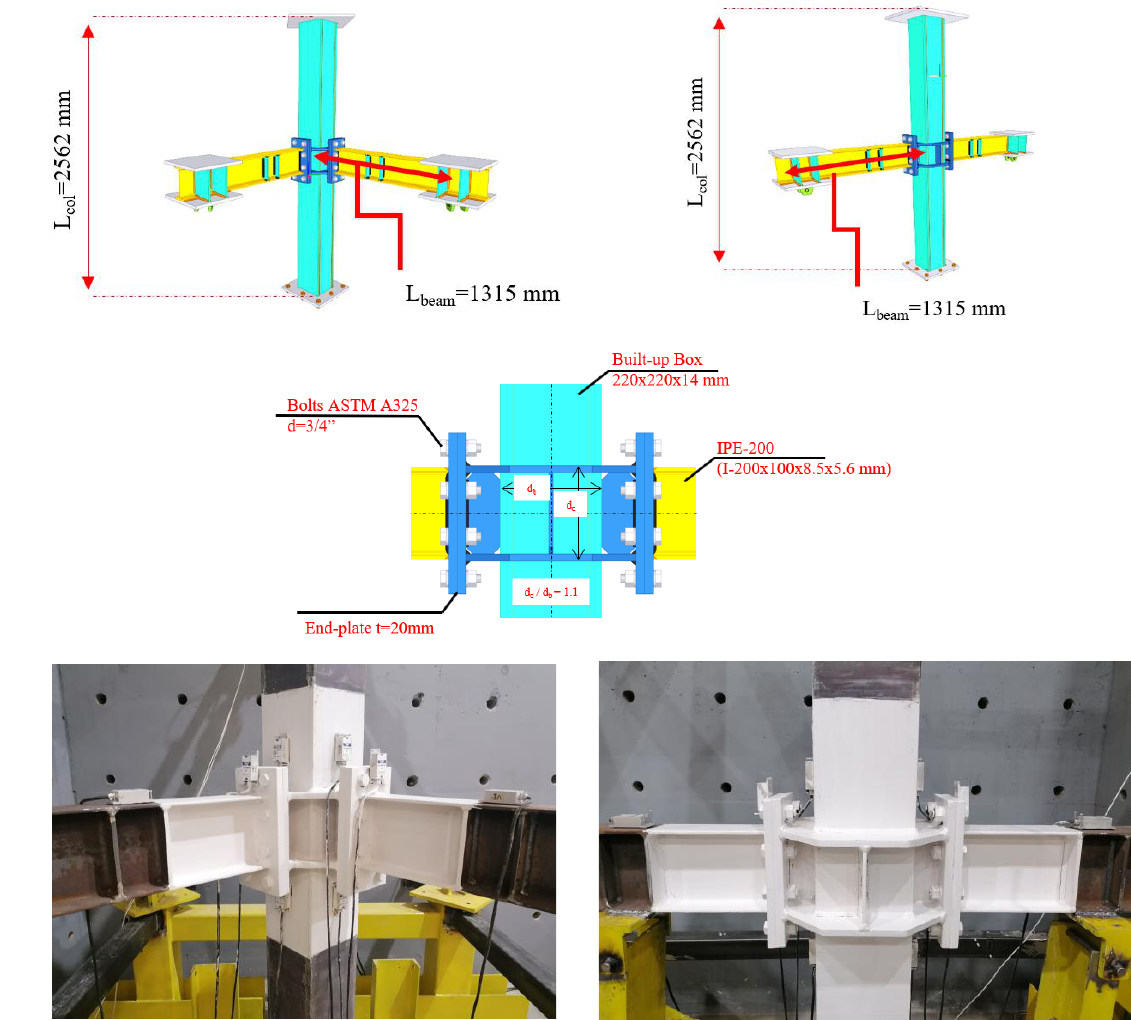
Figure 1. Test assemblies and geometries of the specimens.